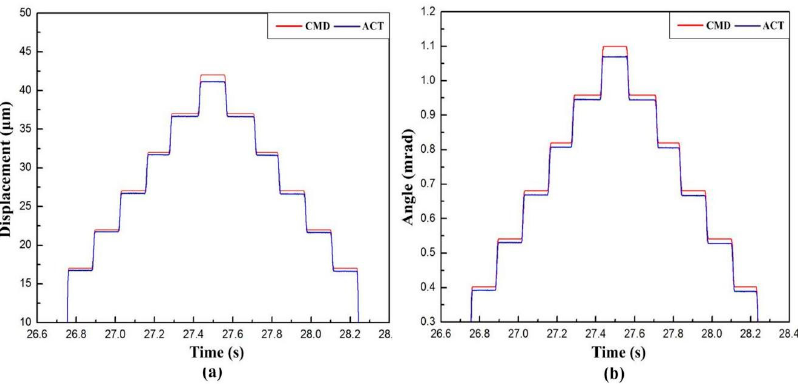
Figure 12. Experimental results of the ( a ) motion stroke of the lever output end and ( b ) rotational angle of the VPD.